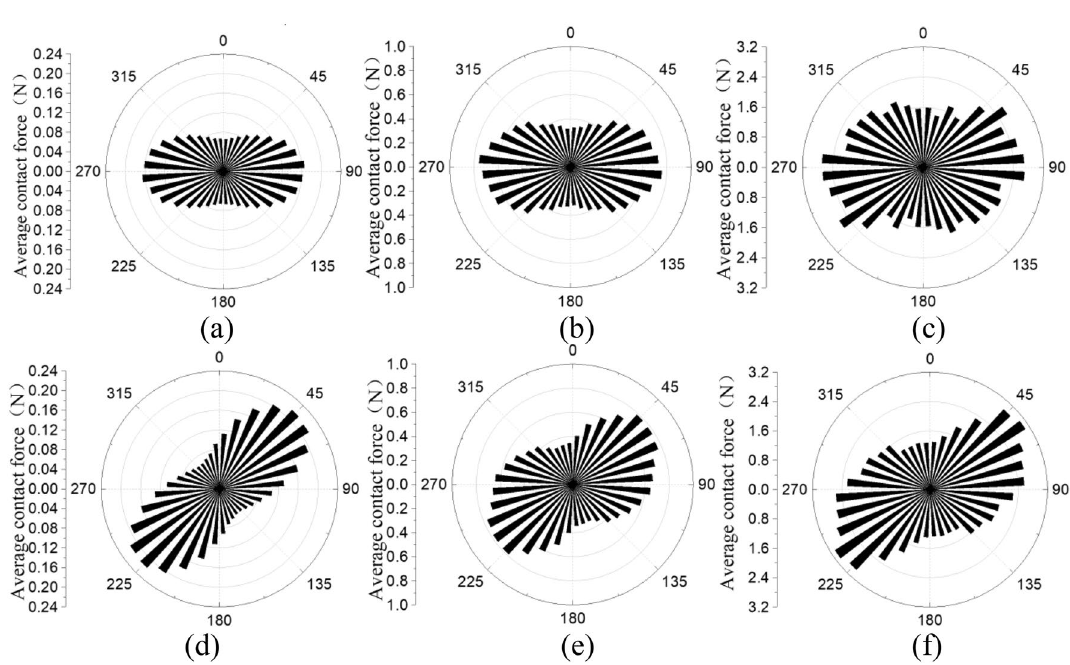
Figure 9. Distribution of average contact force: ( a ) 1D after consolidation, ( b ) 2D after consolidation, ( c ) 4D after consolidation, ( d ) 1D at 40% shear strain, ( e ) 2D at 40% shear strain, ( f ) 4D at 40% shear